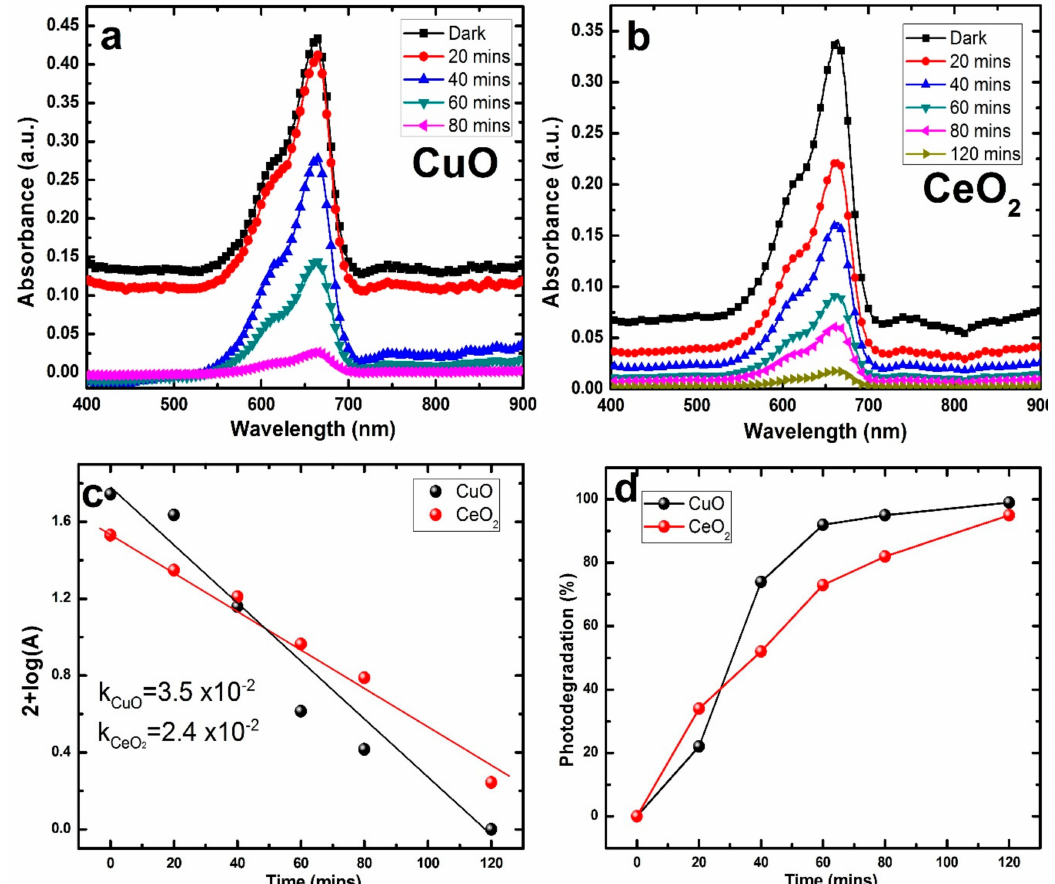
Figure 7. UV-vis absorption spectra of the Methylene Blue solution during the decomposition reaction under UV irradiation in the presence of ( a ) CuO NF and ( b ) CeO 2 NF; ( c ) shows the percentage of the degradation of MB over the reaction time; ( d ) Pseudo-first-order kinetics curves of the degradation of MB under UV irradiation in the presence of CuO NF ( a ) and CeO 2 NF ( b ). Experimental conditions: CuO NF and CeO 2 NF = 20 mg and MB = 20 mg L − 1